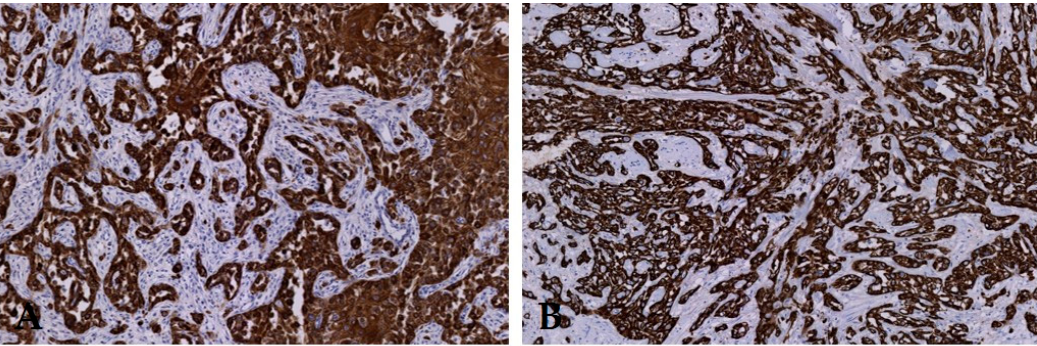
Figure 4. ( A ) Metastasis in a lymph node and ( B ) primary tumor of the same patient with CK AE1/AE3 expression. Original magnification 200×.